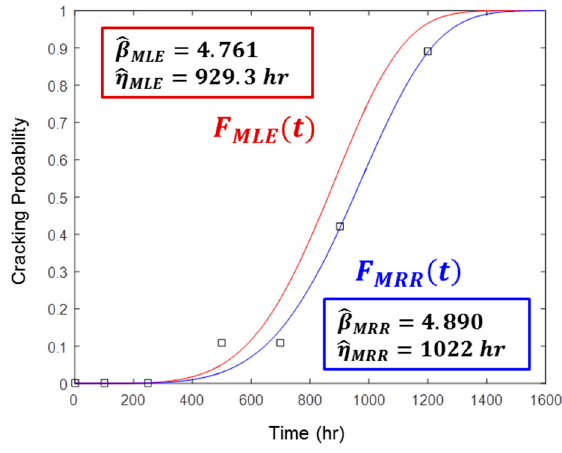
Figure 3. Comparison of different Weibull curves estimated by MRR or MLE from the test data in Table 1. The blue line is the Weibull curve estimated by MRR and the red line is that by MLE. The black squares are the median rank points.